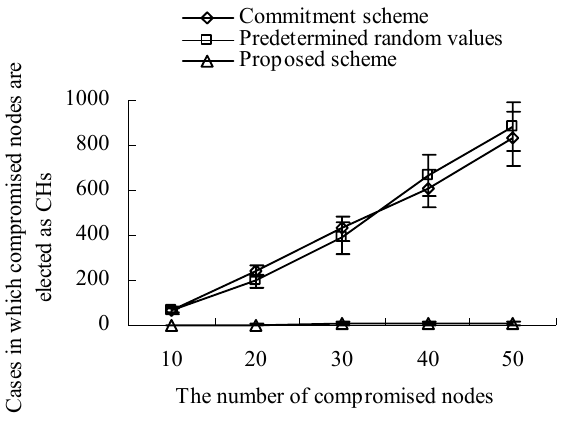
Figure 6. Cases in which compromised nodes are elected as CHs vs. compromised nodes.